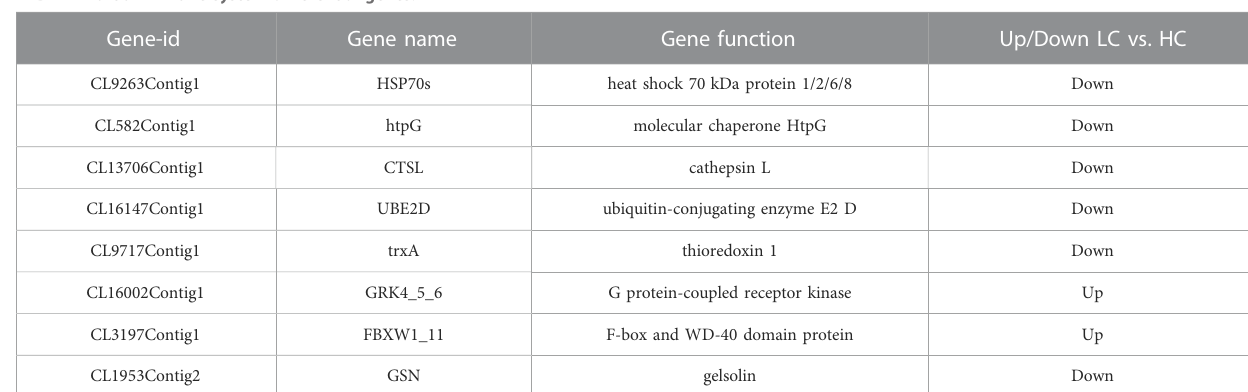
TABLE 4 Partial immune system differential